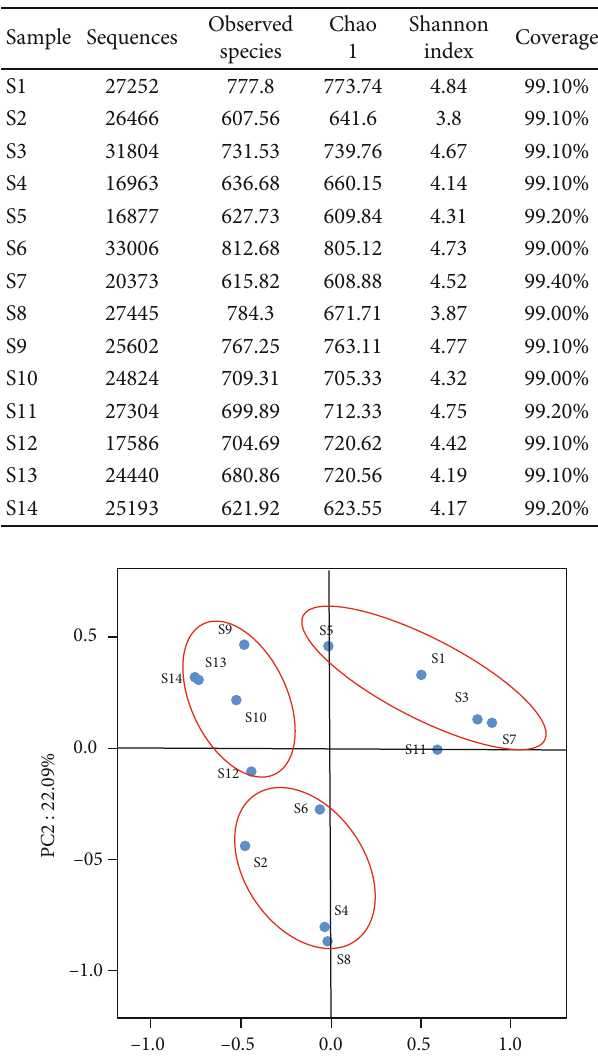
Figure 3: PCoA plot comparing bacterial communities from di ff erent 20 d SS-AD